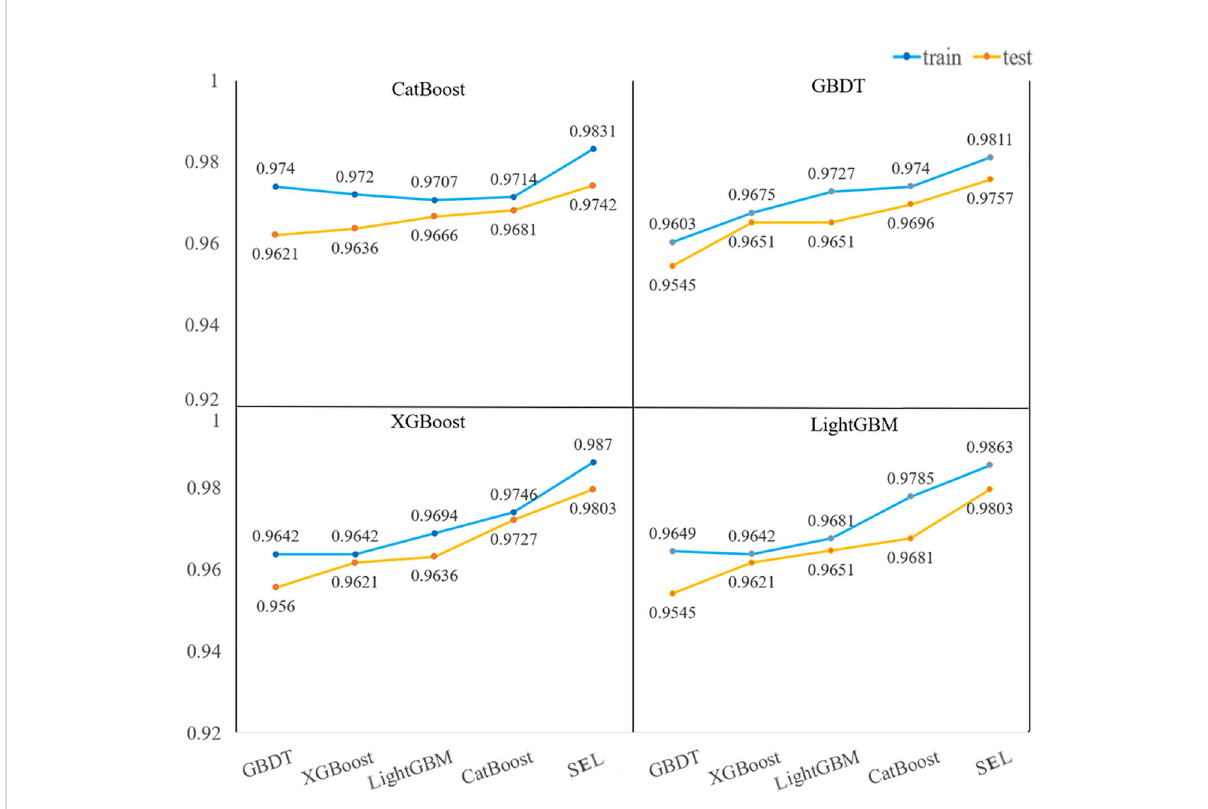
FIGURE 8 The training and test set accuracies of the feature wavelengths selected by the four variable selection methods as the model